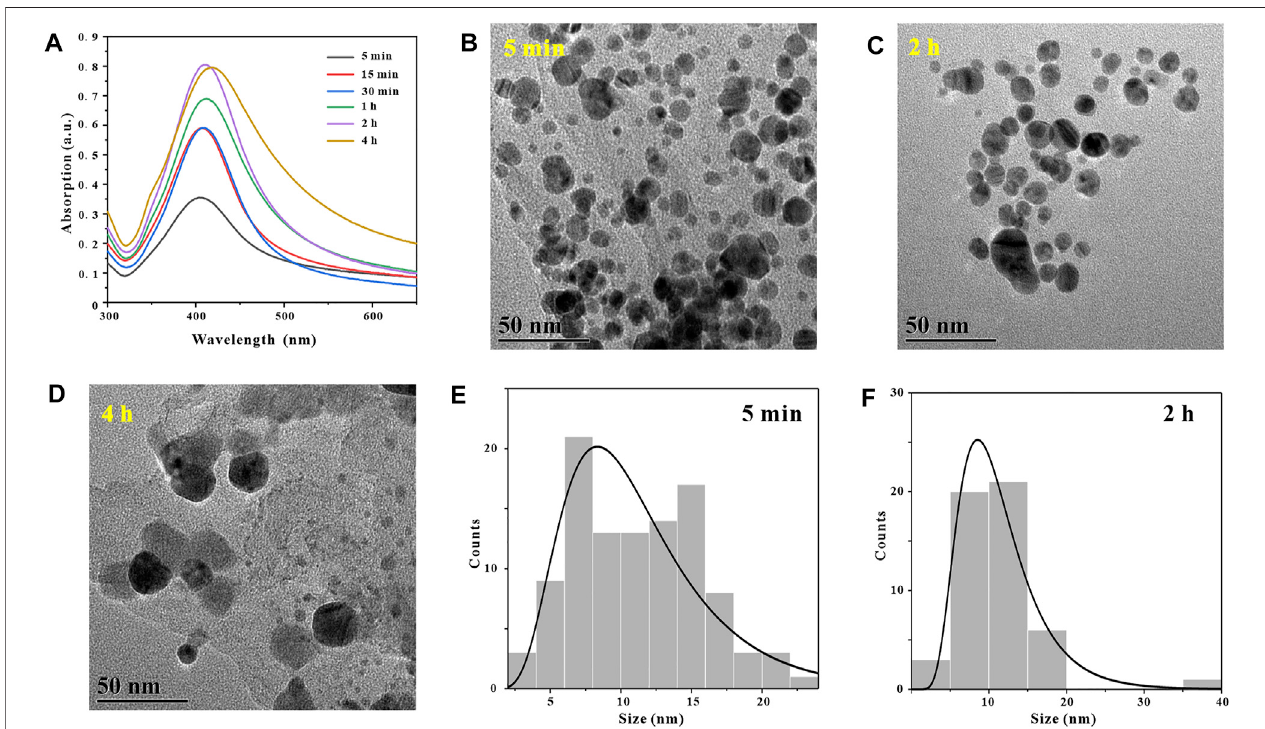
FIGURE5| Optimizationofreaction time, UV-visspectraofGO-AgNPs under differentreactiontimes conditions (A) ,TEM image ofGO-AgNPs at reaction time t= 5 min (B) , t = 2 h (C) , t = 4 h (D) , panels (E,F) are the particle size distributions of AgNPs in panels (B,C) , respectively.